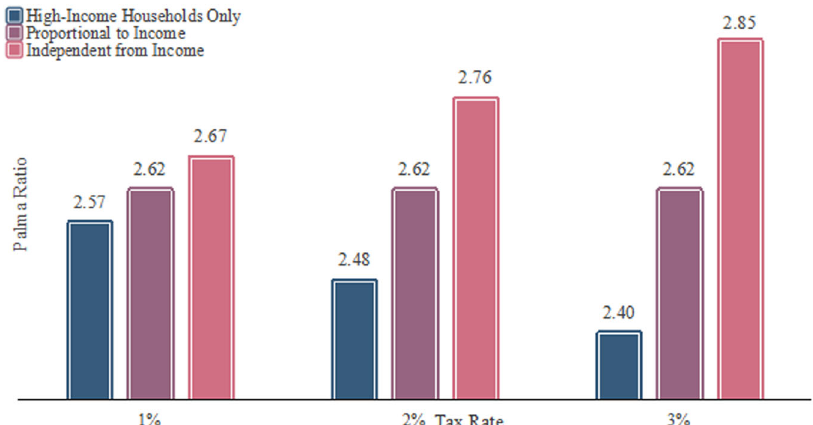
Fig. 3 Impacts of tax payments on the Palma ratio. Shows impacts of tax payments on the Palma ratio: the legends “ High-income Households Only ” , “ Proportional to Income ” , and “ Independent from Income ” refer to tax payments by high-income households, proportional to income, and independent from income.